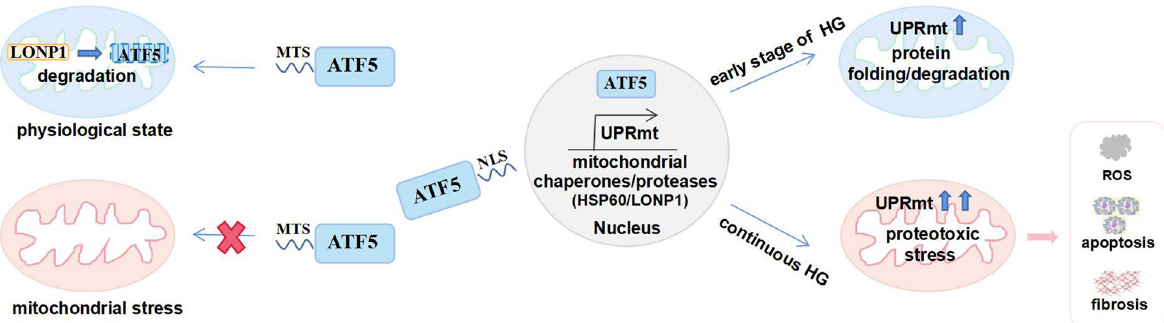
Fig. 9 Schematic diagram depicting the mechanism of which ATF5-modulated UPRmt in the tubular injury under diabetic conditions. ATF5 coordinates with the UPRmt to play a protective role against tubular cell damage in the early stage of HG exposure (6 h), while ATF5 induces continuous UPRmt activation, which increases tubular cell injury and leads to tubulointerstitial fibrosis under sustained HG exposure. ATF5 activating transcription factor 5, UPRmt mitochondrial unfolded protein response, HSP60 heat shock protein 60, LONP1 Lon peptidase 1, mitochondrial, HG high glucose, MTS mitochondrial targeting sequence, NLS nuclear localization